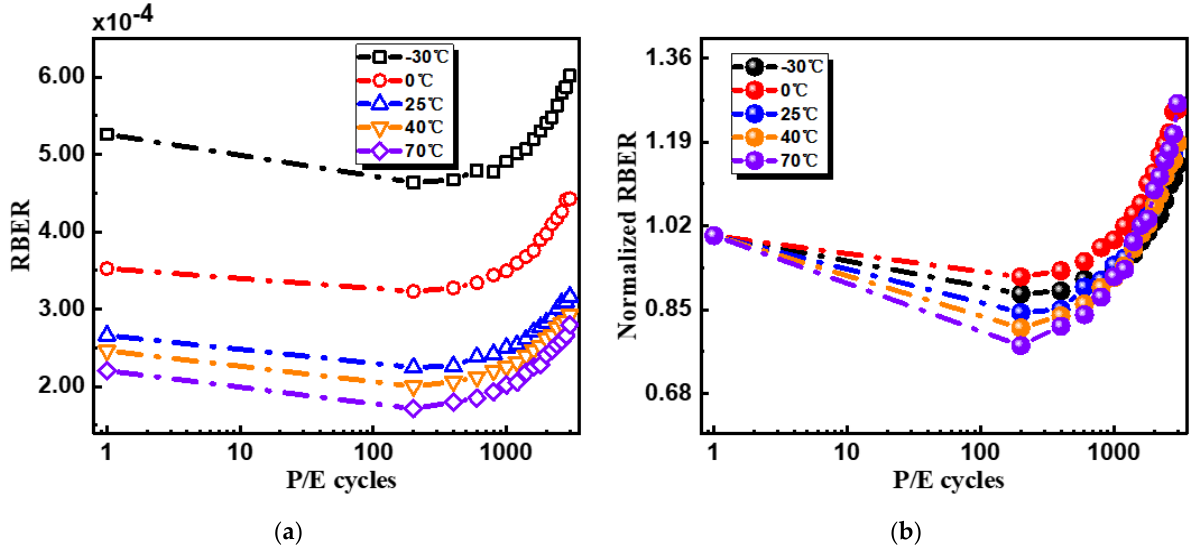
Figure 3. ( a ) Measured RBER with P/E cycling at different temperatures; ( b ) normalized RBER to study RBER degradation.